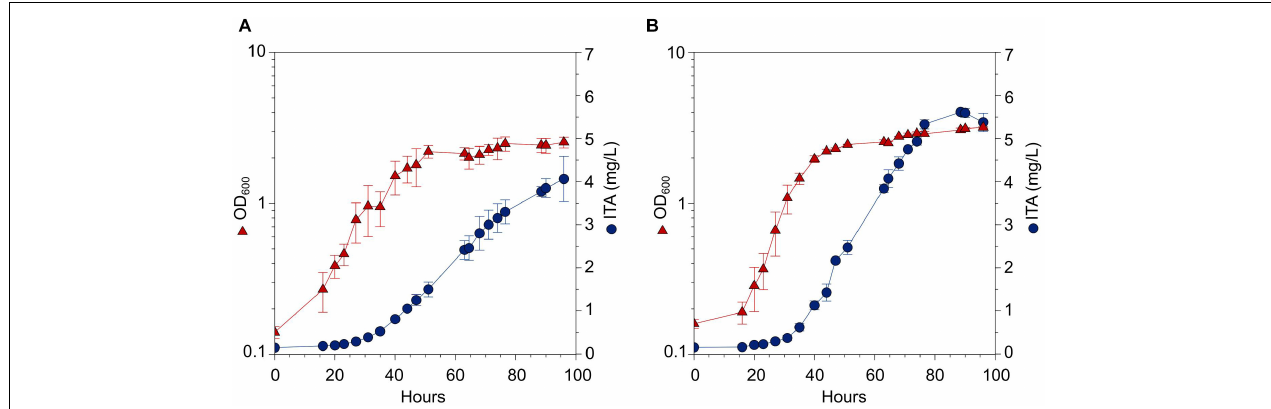
FIGURE 7 | Fed-batch bioreactor experiment of WT_CAD grown in HM medium with methanol as the carbon source. The duration of the fed-batch cultivation was 96 h. (A) Dissolved O 2 saturation level was maintained at 25% and pH control with 1 M NaOH. (B) Dissolved O 2 saturation level was maintained at 60% and pH control with 1 M NH 4 OH. Error bars represent one standard